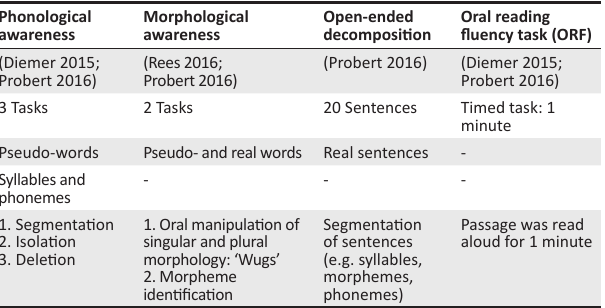
TABLE 1: Summary of the tasks used. Phonological